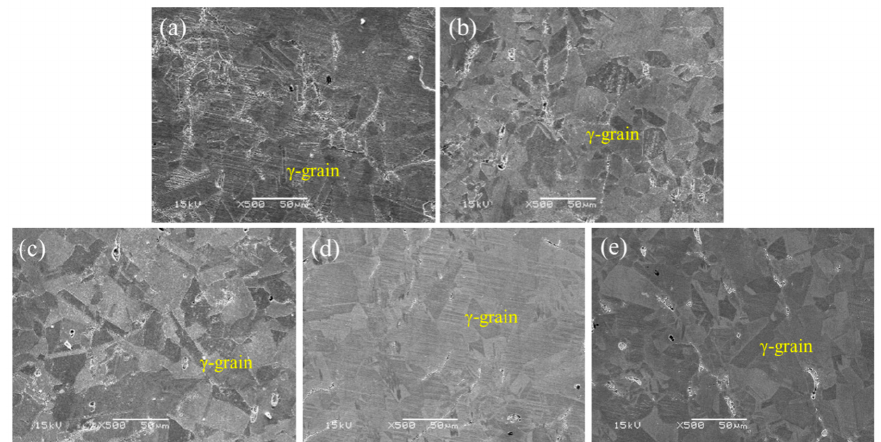
Figure 1. SEM images of forged 304 stainless steel with different copper contents: ( a ) 304–0.2Cu, ( b ) 304–0.5Cu, ( c ) 304–1Cu, ( d ) 304–1.8Cu, and ( e ) 304–2Cu.